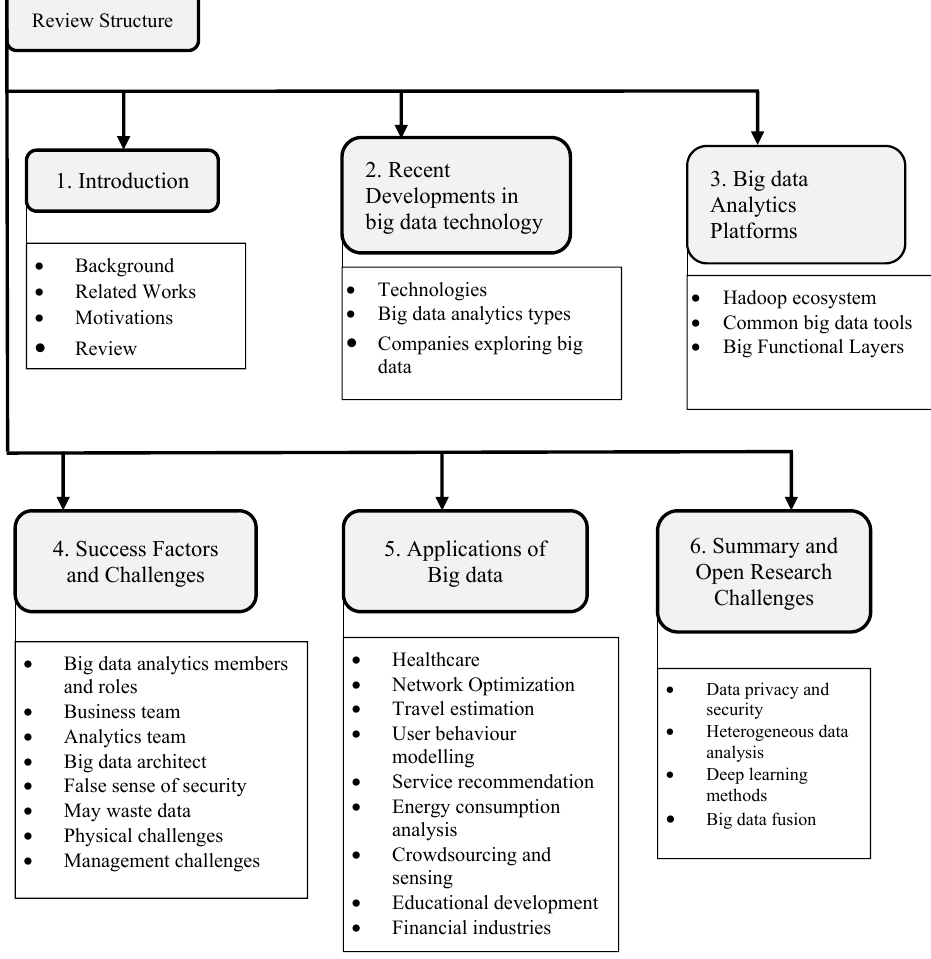
Figure 1. Structure of the review paper .